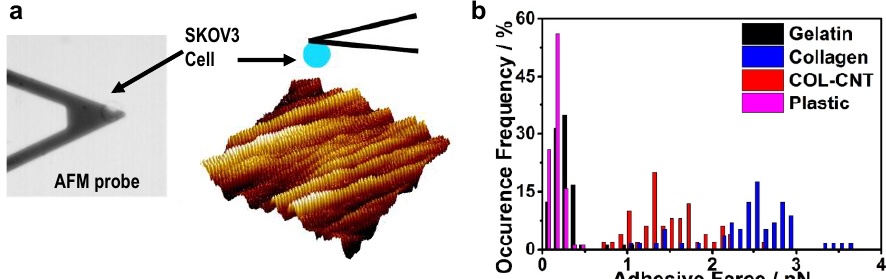
Figure 4. Cell adhesion on various matrices. ( a ) Illustration of the modification of a single cell on a PDL-coated AFM cantilever (phase image on the left) and the scheme (on the right) showing the cell adhesion measurement on a COL-CNT matrix. ( b ) Histogram of adhesion forces measured between individual cells and the selected substrates.